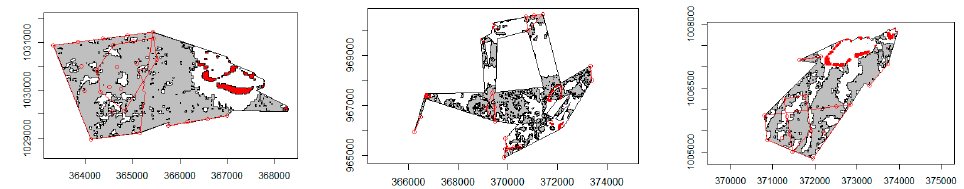
Figure 4. Burned area envelopes over the fire front clusters depicted in Figures 1–3. Gray areas have been mapped as burned using S-2, red polygons correspond to S-2 fire detections and red outlines to VIIRS fire detection envelopes. Red dots are the center coordinates of the VIIRS fire detection pixels.